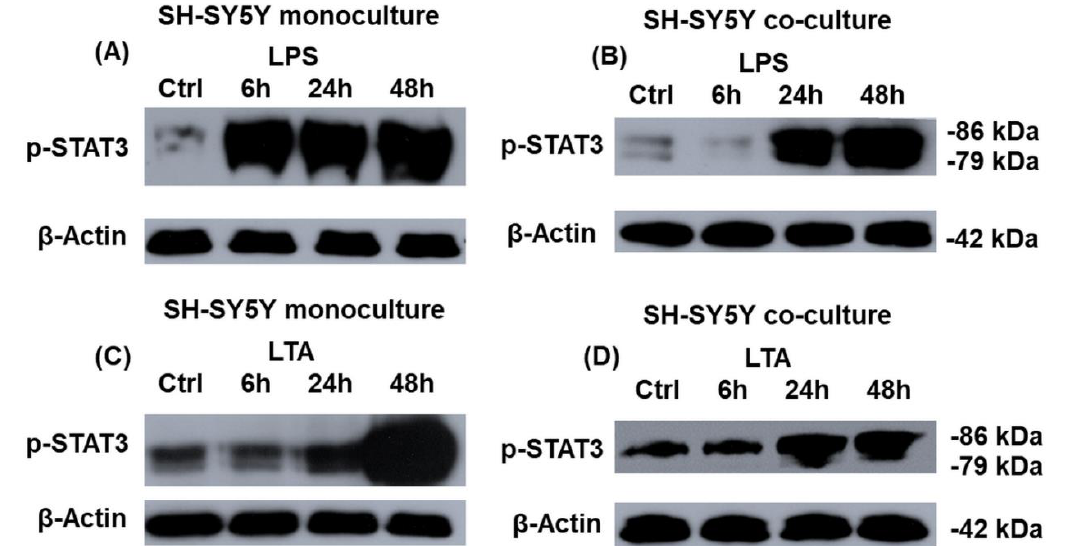
Figure 7. Western blot analyses of phospho-STAT3 in mono- ( A , C ) and co-cultured ( B , D ) SH-SY5Y cells. SH-SY5Y cells were collected and pelleted cells were lysed and their protein contents were measured. The same amount of protein (15 µg) from each sample was separated by SDS-PAGE using 12% polyacrylamide gel, transferred by electroblotting to nitrocellulose membranes and probed with anti-p-STAT3 polyclonal rabbit antibody according to the manufacturer’s protocol. p-STAT3 reflects the activation of JAK/STAT signaling pathway affecting HAMP transcription. The experiments were repeated at least three times. Optical density analyses can be found in Figure S2.